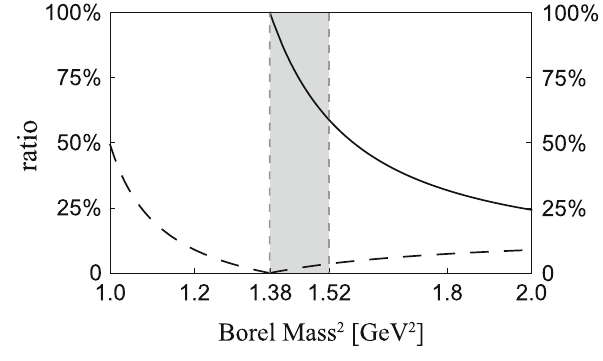
(cid:9) (cid:9) (cid:9) Π 2 (cid:9) (solid) and /(Π Π ) 11 22 12